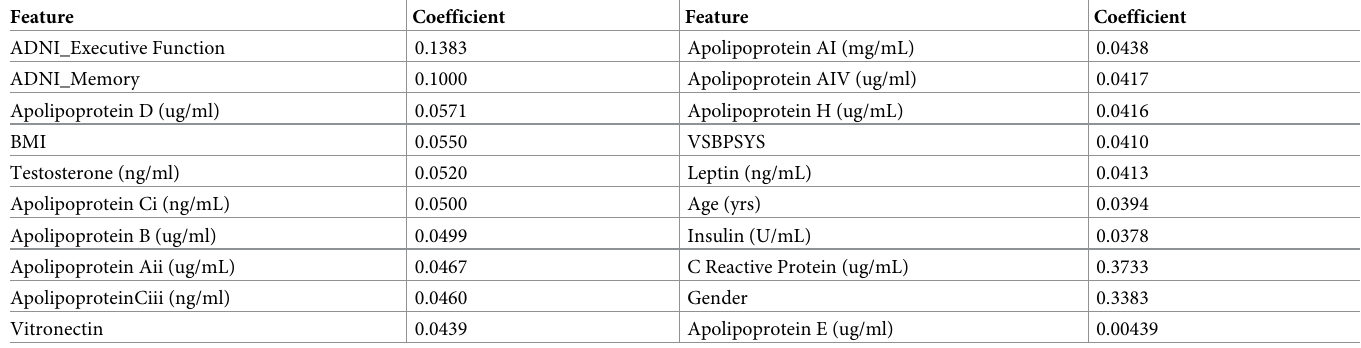
Table 1. GINI Importance of features including plasma